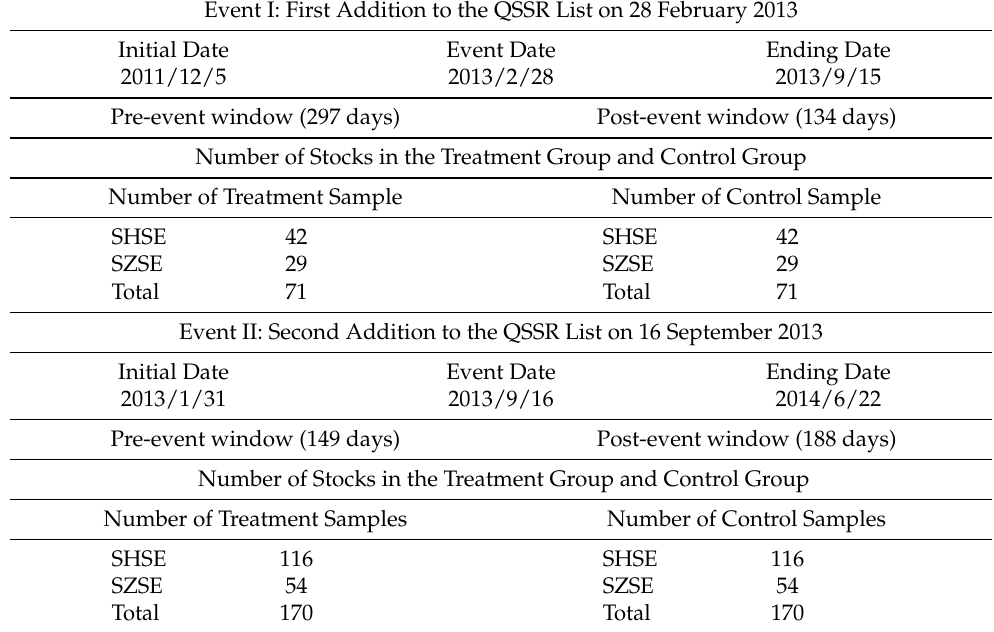
Table 3. Sample description for two events on additions to Qualified Securities for Short-sale Refinancing (QSSR)